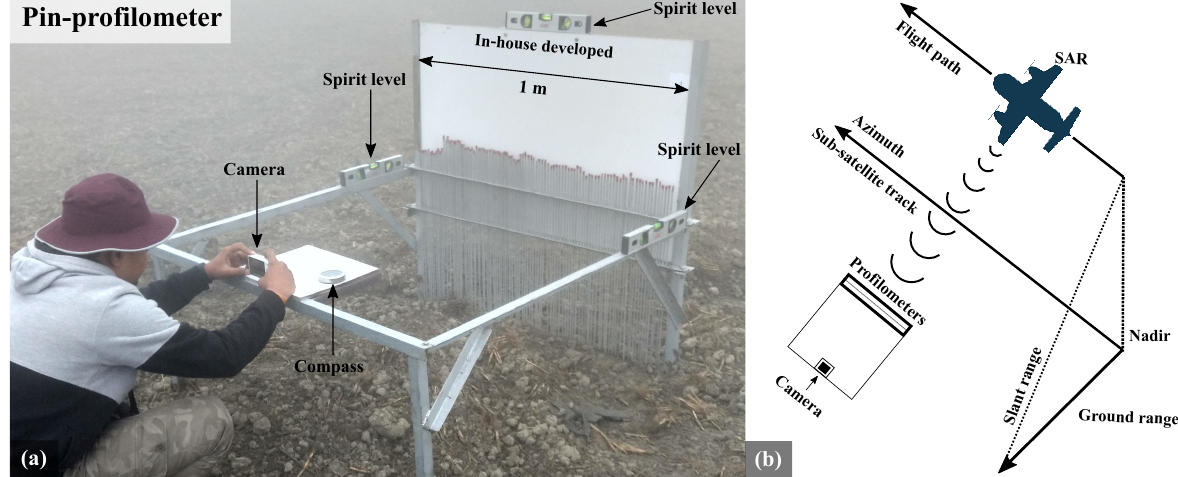
Figure 2. ( a ) Pin-profilometer used to measure surface roughness in the field. ( b ) schematic on the top right illustrates the acquisition direction of the Sentinel-1 satellite sensor. Surface roughness is measured in the field by keeping the profile-meter parallel to the direction of the